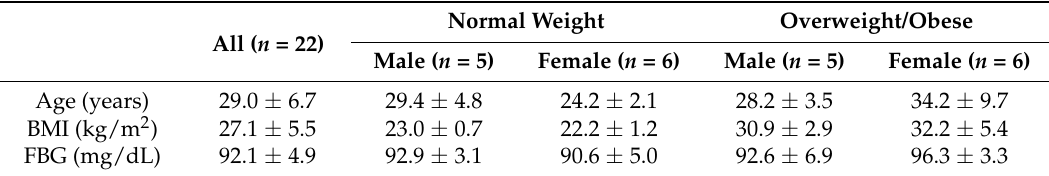
Table 1. Subject